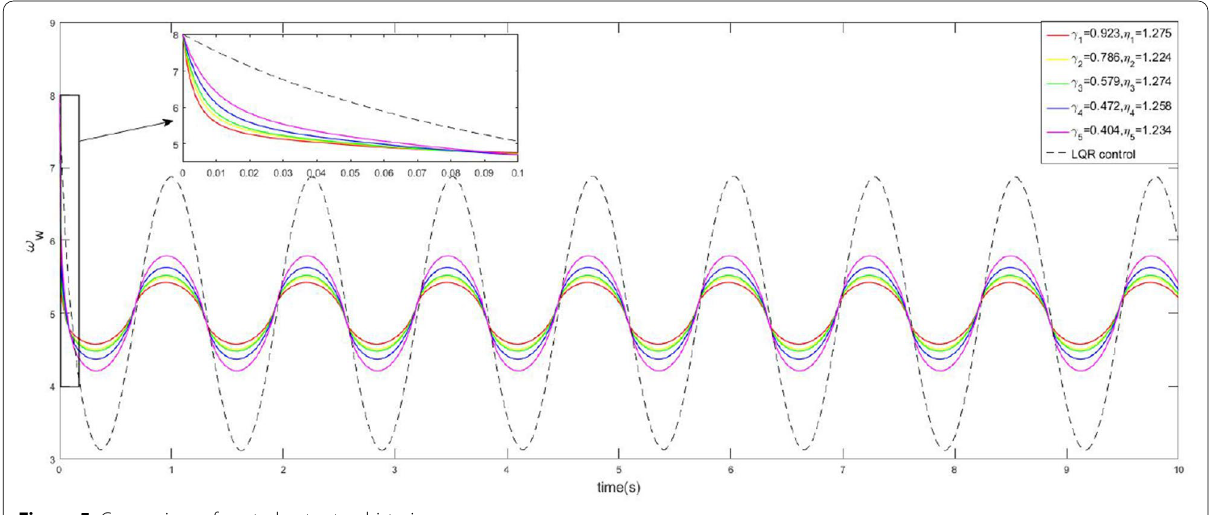
Figure 5 Comparison of control output ω t histories